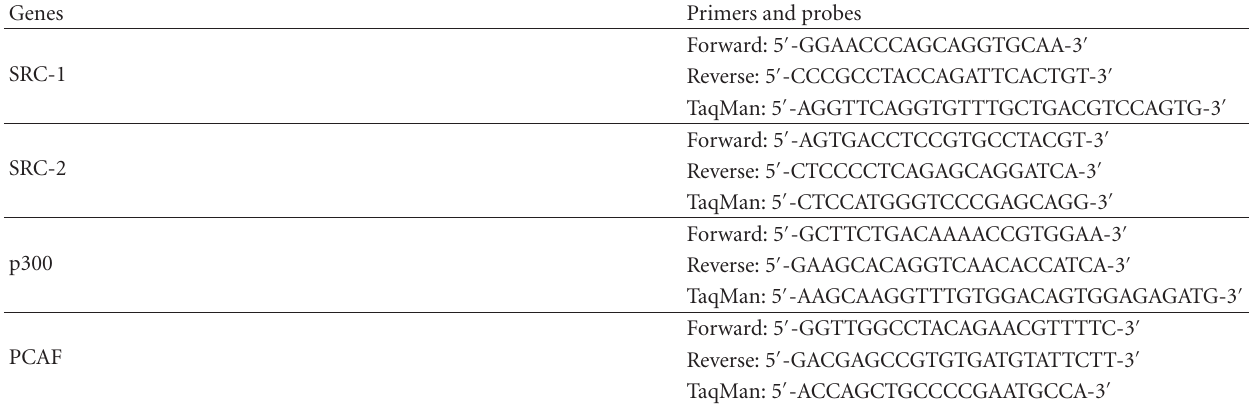
Table 1: Sequences of the primers and TaqMan probes that were used in real-time